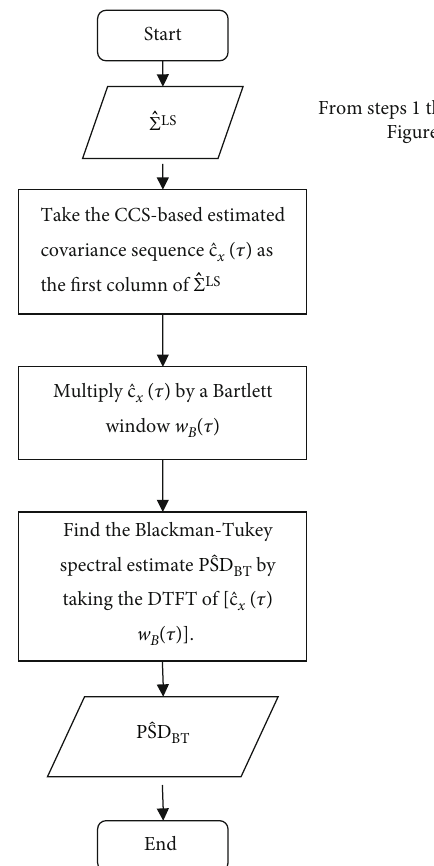
Figure 2: Flowchart of the CCS-based Blackman-Tukey power spectrum